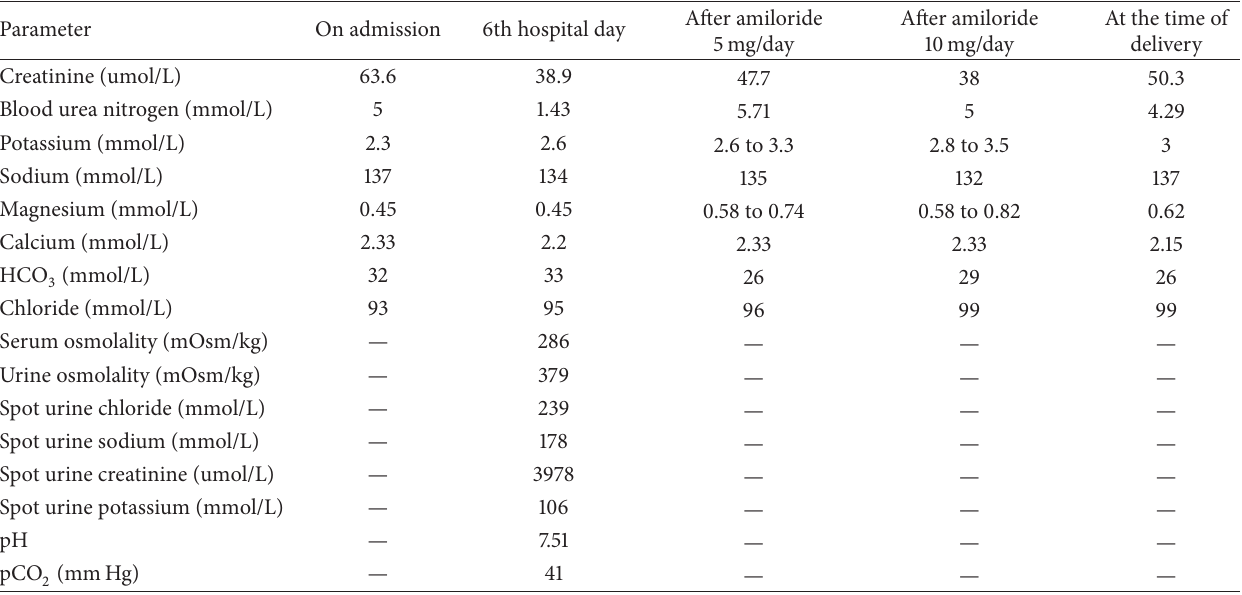
Table 1: Laboratory work-up. Summary of important laboratory tests performed during the patient’s hospitalization. On day 6 of hospitalization, the calculated transtubular potassium gradient (TTKG) is 30.77, consistent with renal potassium wasting.